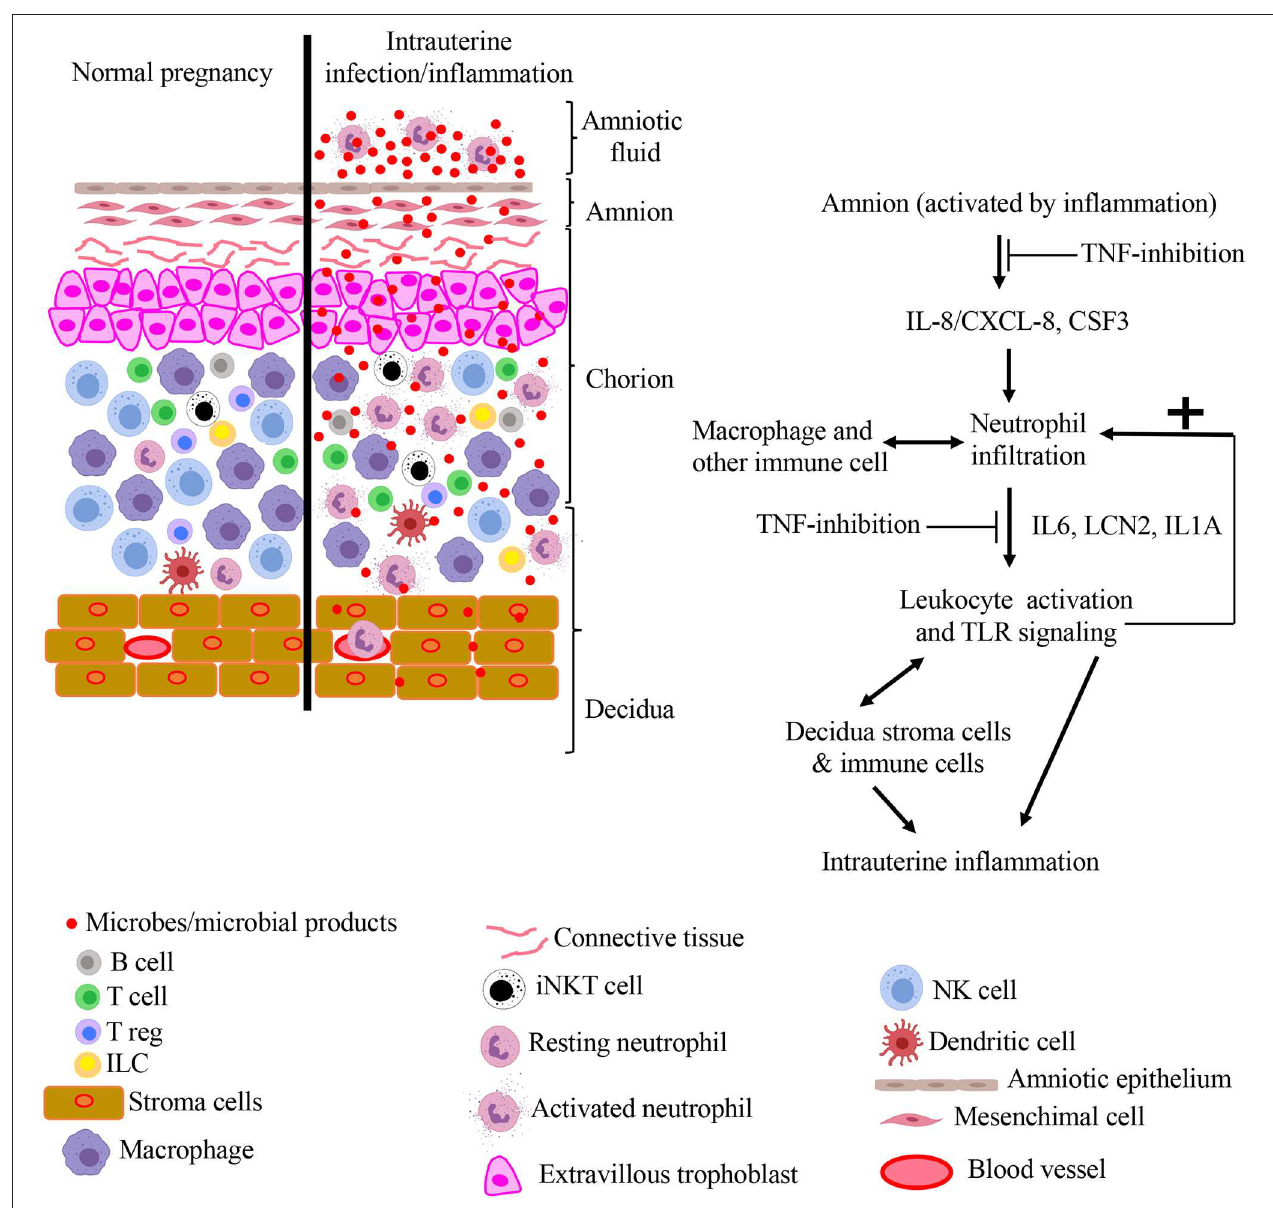
FIGURE 9 | Model for pathogenesis of intrauterine infection/inflammation. Representative cells in the different tissue layers of fetal membrane are shown. The left panel in figure depicts normal pregnancy and the right panel shows changes during IUI. Inflammatory products and microbial products (red dots) in the amniotic fluid and chorio-decidua activate the amnion, resulting in the release of leukocyte chemoattractants in a TNF-dependent manner. Based on a previous study, IL-1 signaling also inhibits multiple pathways in IUI (10). Leukocytes accumulate at chorio-decidua junction, get activated, and greatly amplify the inflammation at the maternal-fetal interface possibly interacting with each other and resident